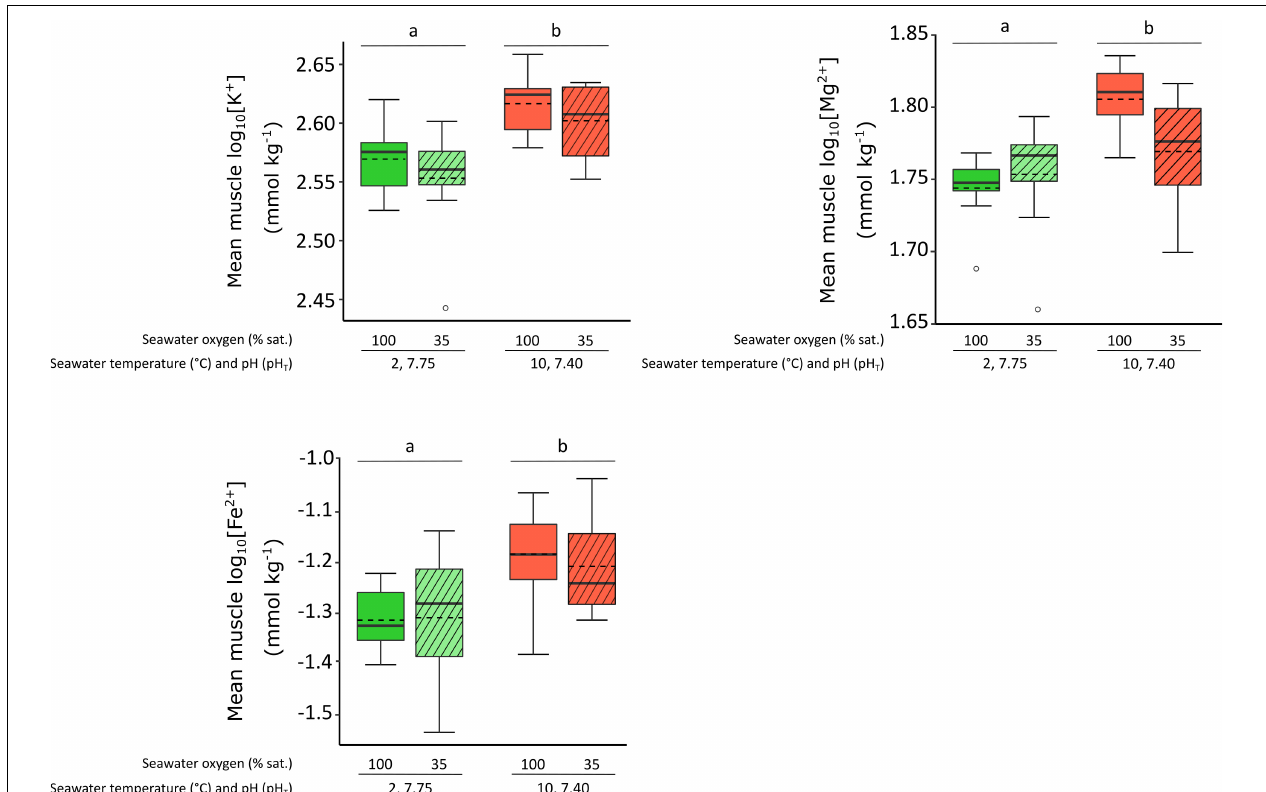
FIGURE 3 | The effect of exposure to elevated temperature and low pH combined (i.e., current and future environmental horizon scenarios), in isolation and combined with low oxygen on mean muscle log 10 [K + ], [Mg 2 + ] and [Fe 2 + ] (mmol kg − 1 ± SE) of female P. borealis . Box plots represent treatment, with plain lines representing the median, dotted lines representing the mean. Lower case letters identify significant differences ( p < 0.05) between treatments, empty circles represent extreme values exceeding the 95% quantile for each